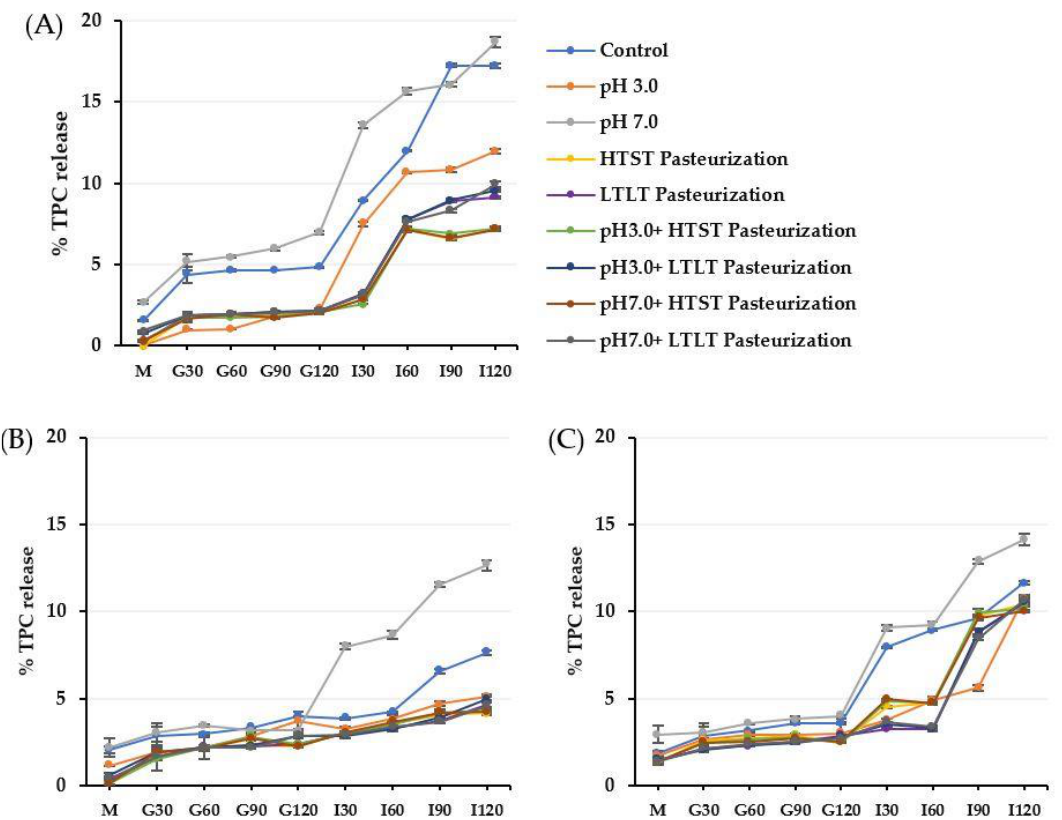
Figure 4. % TPC release of alginate ( A ), alginate/maltodextrin ( B ), and alginate/inulin ( C ) hydrogel beads in simulated gastrointestinal fluid. M = simulated oral phase, G30 – G120 = simulated gastric phases at 30, 60, 90, and 120 min, respectively, I30 – I120 = simulated intestinal phases at 30, 60, 90, and 120 min, respectively. The error bars indicate the standard deviation (SD) of the data.